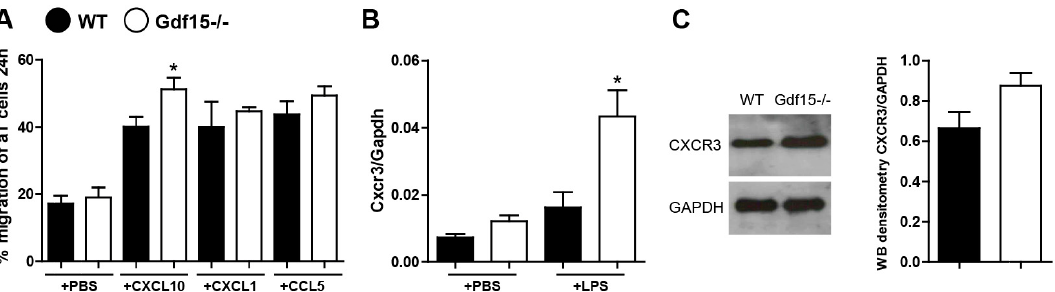
Figure 6. Quantification of T cell migration and CXCR3 expression. ( A ) T cells from the spleens of WT and GDF15-deficient mice were isolated and migration assays were performed. The percentage of migrated T cells towards the chemokines CXCL10, CXCL1, and CCL5 was quantified after 24 h ( n = 4 per group, one-way ANOVA, * p < 0.05). ( B ) Cxcr3 expression levels in LPS-stimulated or untreated T cells were quantified by real-time PCR. Data are shown as means of the ratio of the Cxcr3 mRNA vs. Gapdh mRNA ( n = 4 per group, one-way ANOVA, * p < 0.05). ( C ) CXCR3 protein expression levels in LPS-activated T cells were quantified by Western blot. The histogram shows the densitometry of two independent experiments; no statistical analysis was performed. Data are mean ± SEM.